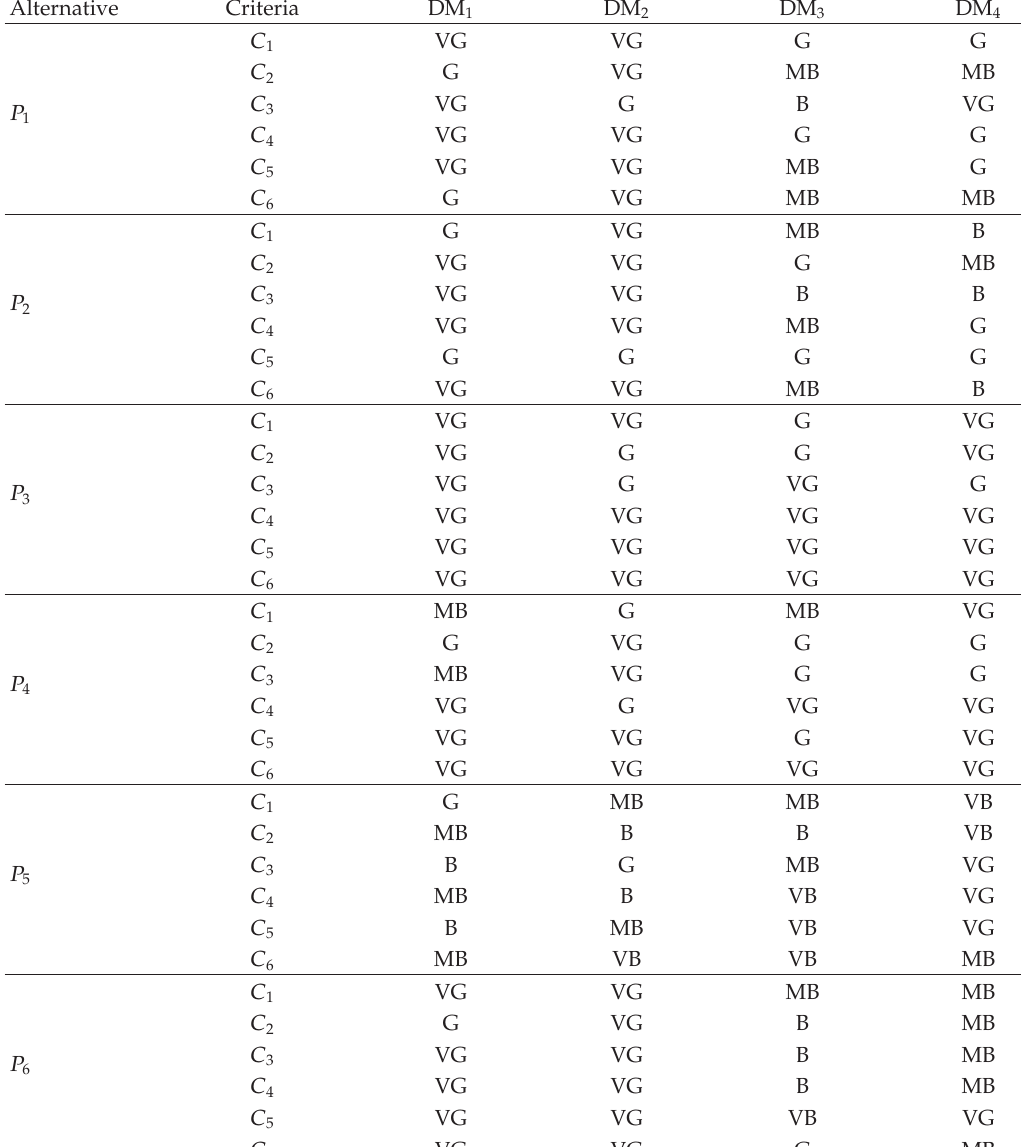
Table 4: The ratings of the